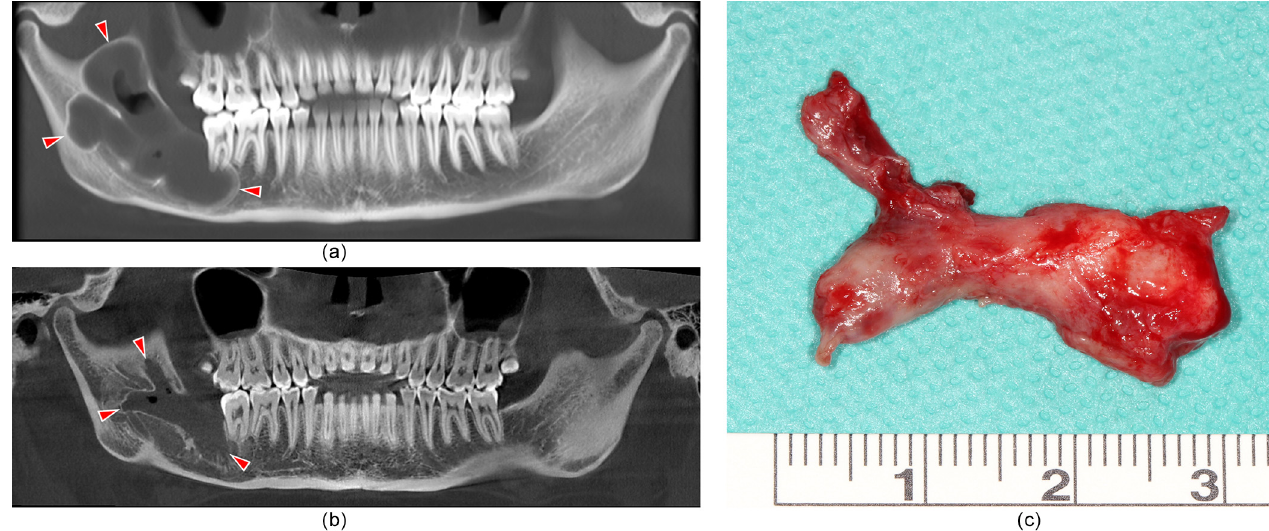
Fig. 3. 3D imaging of a right mandibular OKC in a 18-year-old female. (a) Before decompression protocol, the lesion spread from the swollen apex of the mandibular coronoid process to the centerline of the distal root of the fi rst molar (major axis 55mm). There was high risk of nerve injury because of an intimate relation of the cyst to the inferior alveolar nerve. (b) After 12 months of decompression, the OKC had signi fi cantly shrinken. (c) Enucleation did not harm the inferior alveolar nerve.